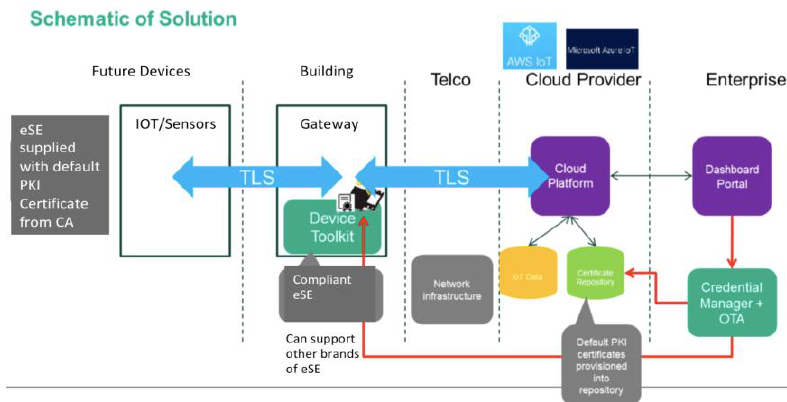
Figure 15. Schematic of the security system.